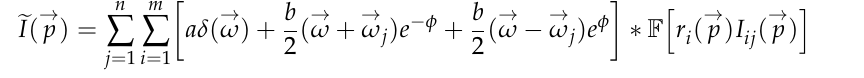
Figure 1. Schematic diagram of multi-image encryption and coding scheme.